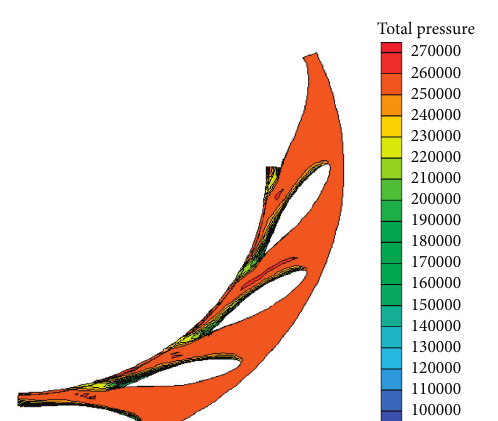
Figure 21: Opening − 6 ° .